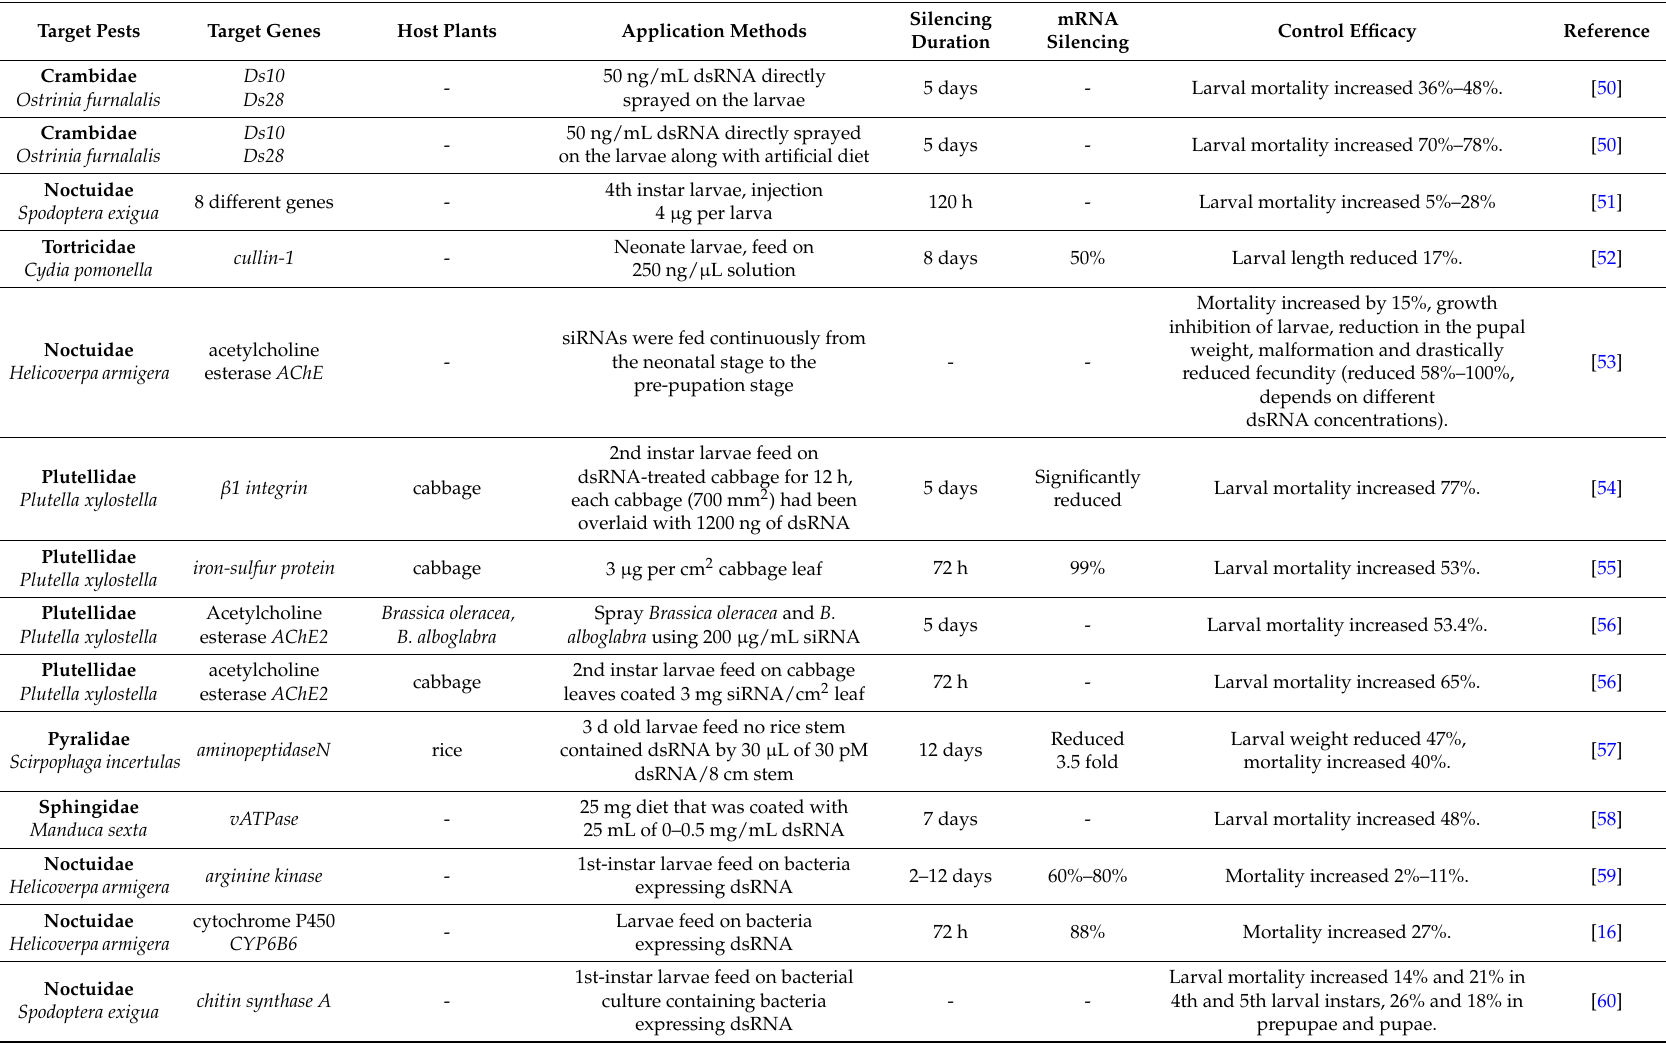
Table 2. Overview on RNAi mediated moth pests control